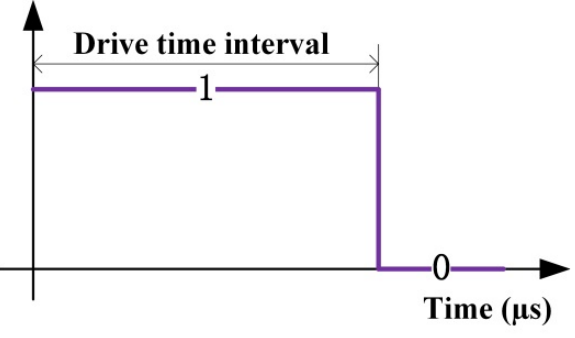
Figure 3. Weight function controlling the e ff ective interval of iterative learning.